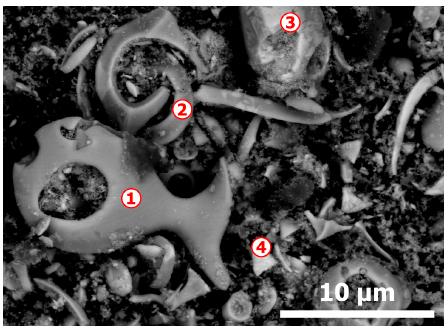
Figure 2. Detailed aspects (backscattered electron micrograph) of initial CAS as revealed by SEM-EDS.